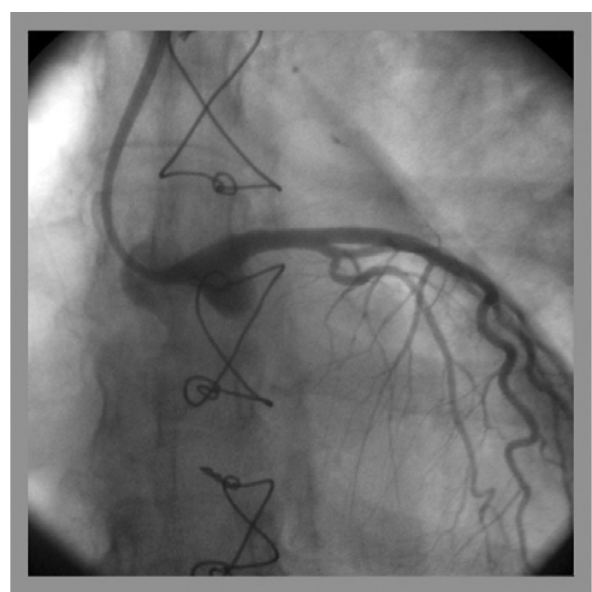
Fig. 2 - Angiocoronariográficos no pós-operatório para avaliar ausência de trajetos fistulosos e/ou “shunts”